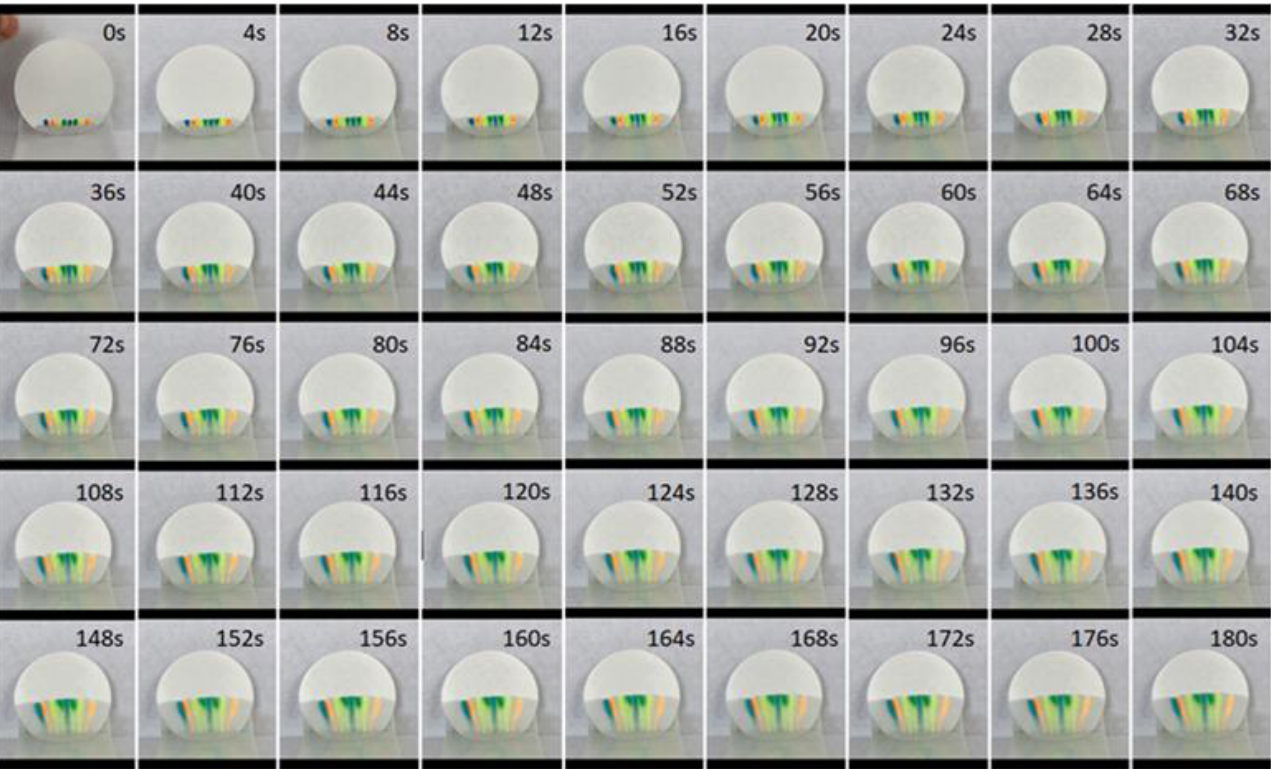
Figure 4. Time series of 45 images of chromatography experiment (sampled every 4 seconds) from a 180 s-long video clip (30 fps × 180 s = 5,400 frames). 180 s-long video clip (30 fps × 180 s = 5,400